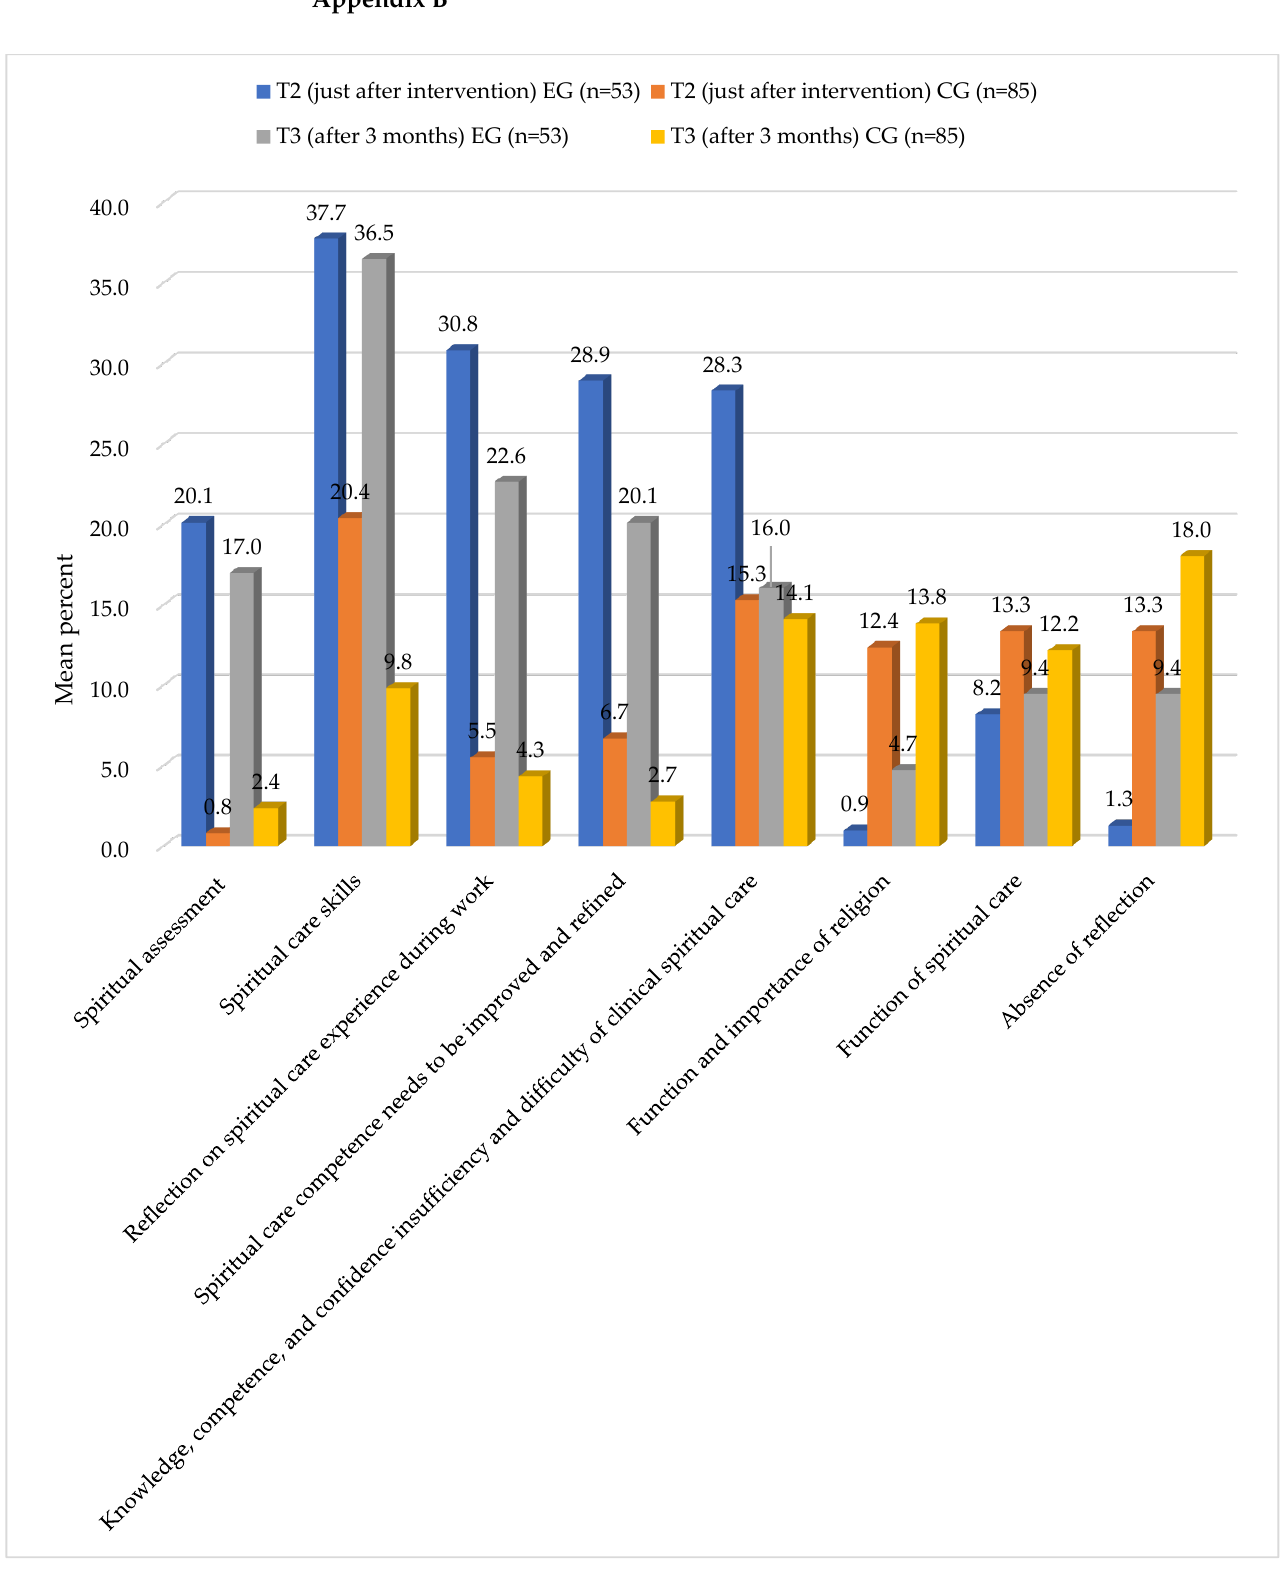
Figure A1. Common subthemes of reflection log of experimental and control groups at two time- points.